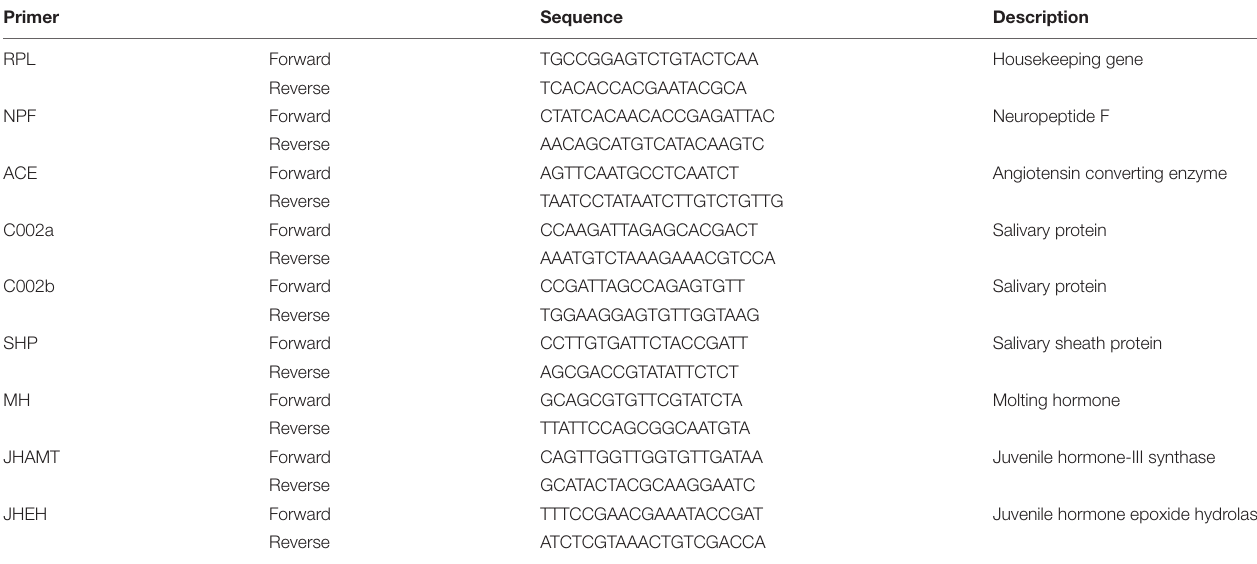
TABLE 2 | The primers used for the qRT-PCR analysis of the related target genes of neuropeptide F (NPF), angiotensin converting enzyme (ACE), salivary proteins (C002a and C002b), salivary sheath protein (SHP), molting hormone (MH), and juvenile hormone (JHAMT and JHEH) of the cotton aphid A. gossypii . Primer